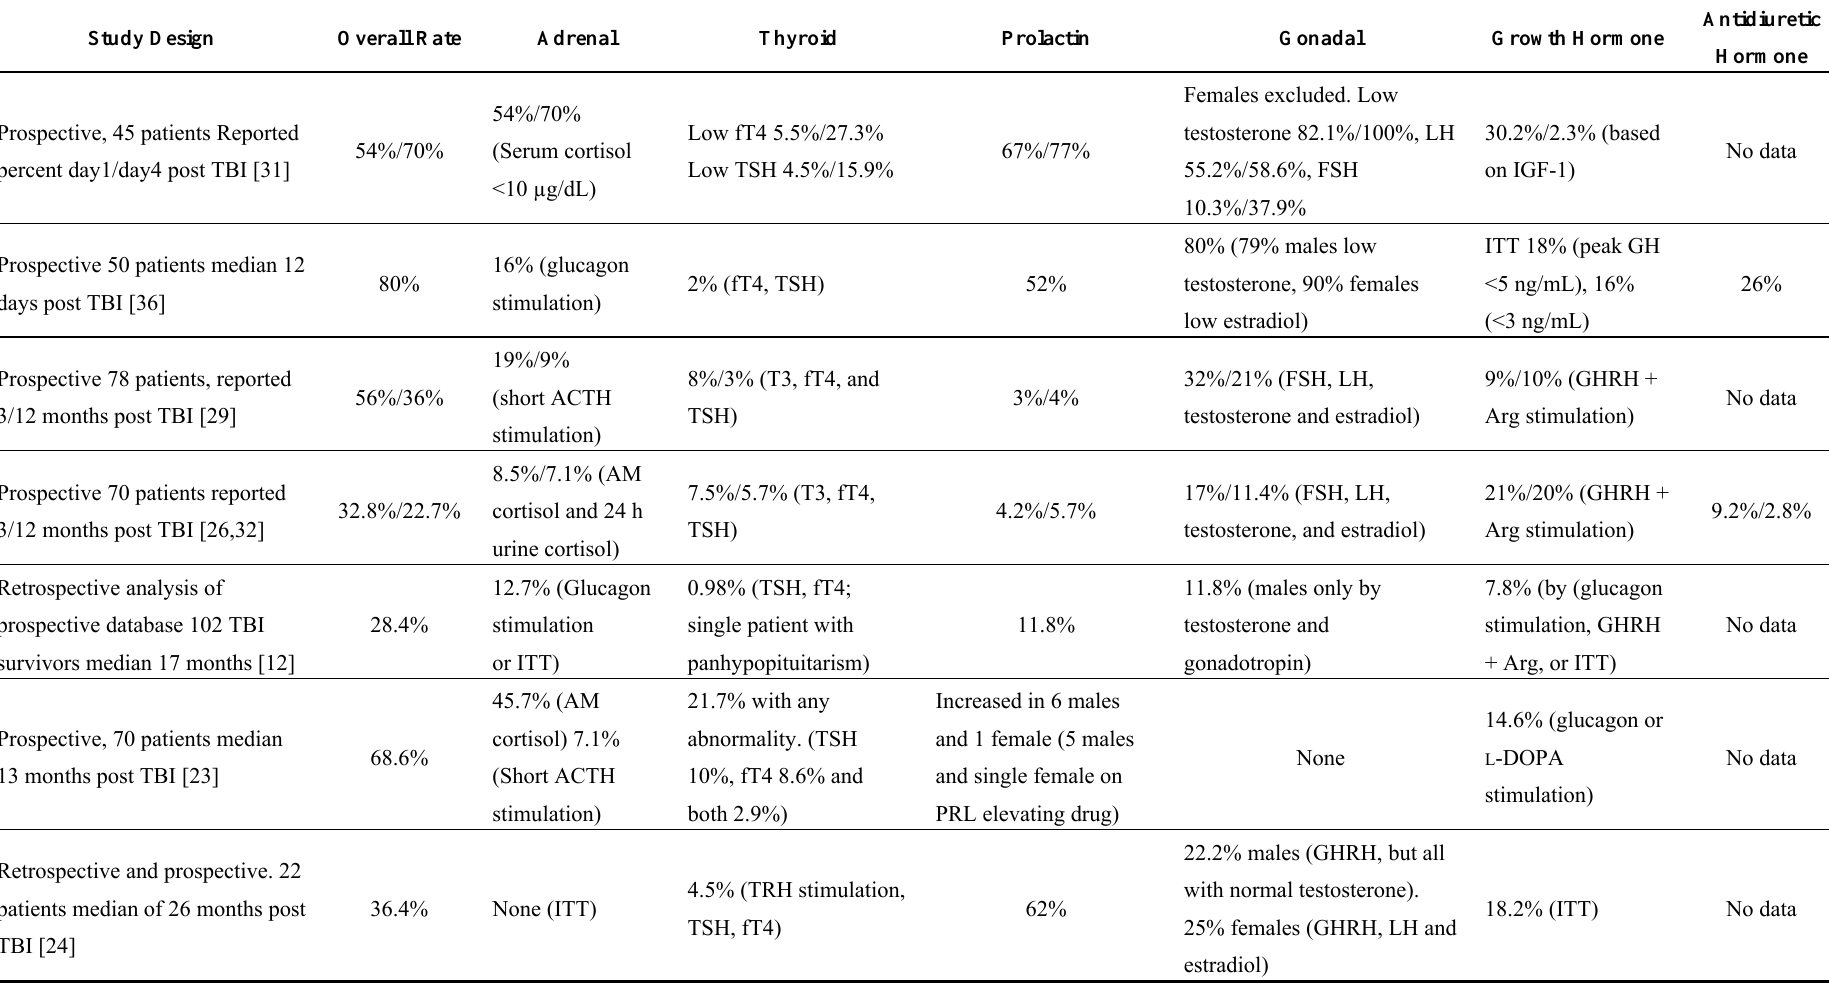
Table 1. Summary of pituitary deficiencies in select